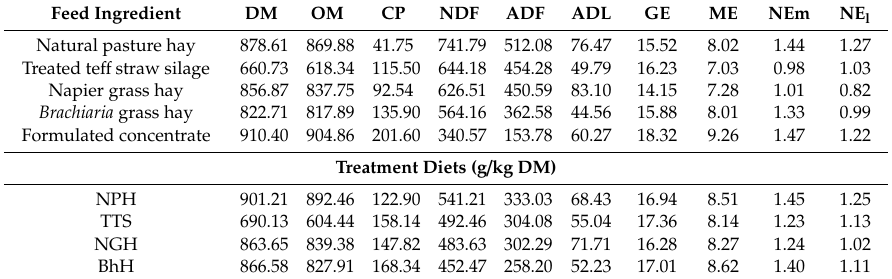
Table 1. Chemical compositions of feed ingredients and the experimental total mixed ration diets. Feed Ingredient